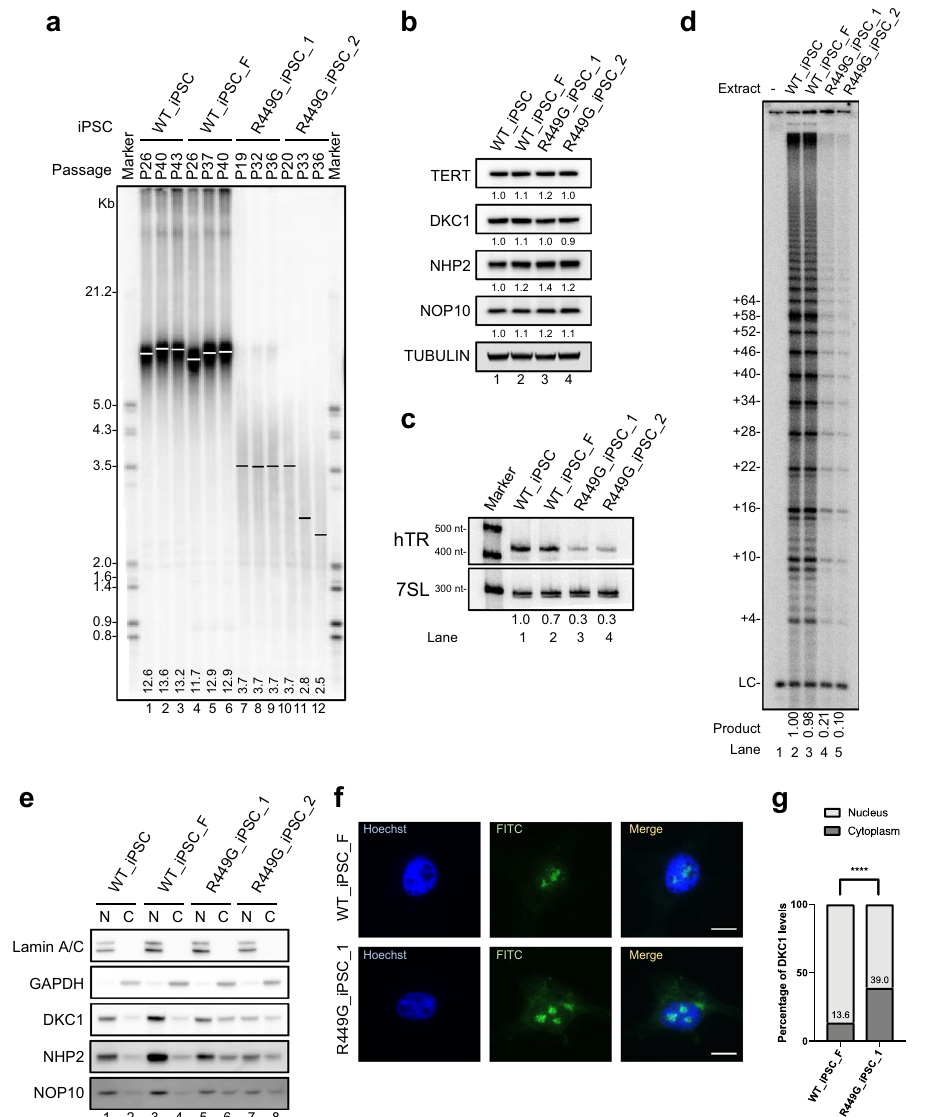
Fig. 5 DKC1_R449G iPSCs exhibit a shorter telomere length, decreased levels of hTR, reduced telomerase activity, and mislocalized DKC1. a Telomere lengths determined by TRF analysis of gDNA prepared from WT_iPSC, WT_iPSC_F, R449G_iPSC_1 and R449G_iPSC_2 cells. b Western blot analysis of cell lysates from WT_iPSC, WT_iPSC_F, R449G_iPSC_1 and R449G_iPSC_2 cells. TUBULIN served as a loading control. c Northern blot analysis of hTR from WT_iPSC, WT_iPSC_F, R449G_iPSC_1 and R449G_iPSC_2 cells. A probe against 7SL RNA served as a loading control. d Direct telomerase activity assay of cell lysates from WT_iPSC, WT_iPSC_F, R449G_iPSC_1 and R449G_iPSC_2 cells. 18- nucleotide telomeric primers (TTAGGG)3 were used. A 32 P end-labeled 18-nucleotide telomeric primers (TTAGGG)3 was added as